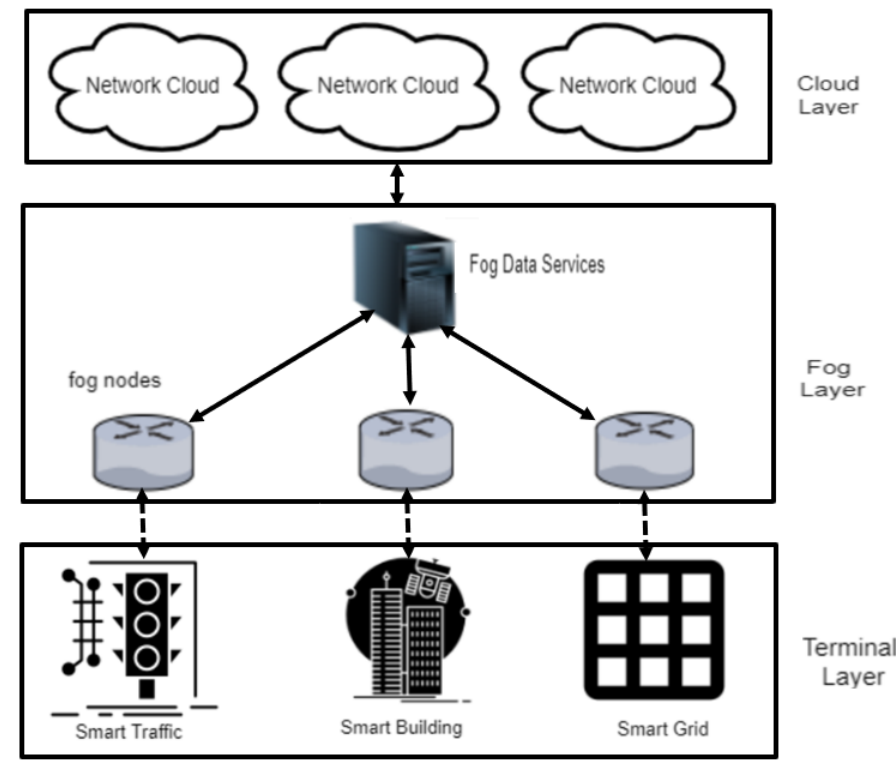
Figure 1. Smart city